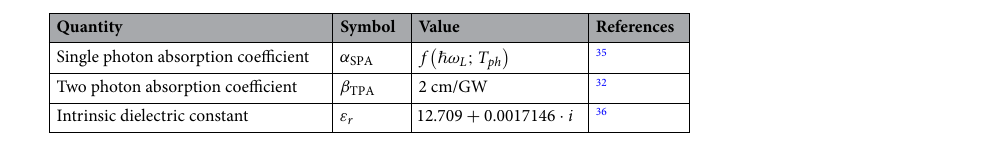
Table 2. Model optical parameters for silicon at 1030 nm laser wavelength.